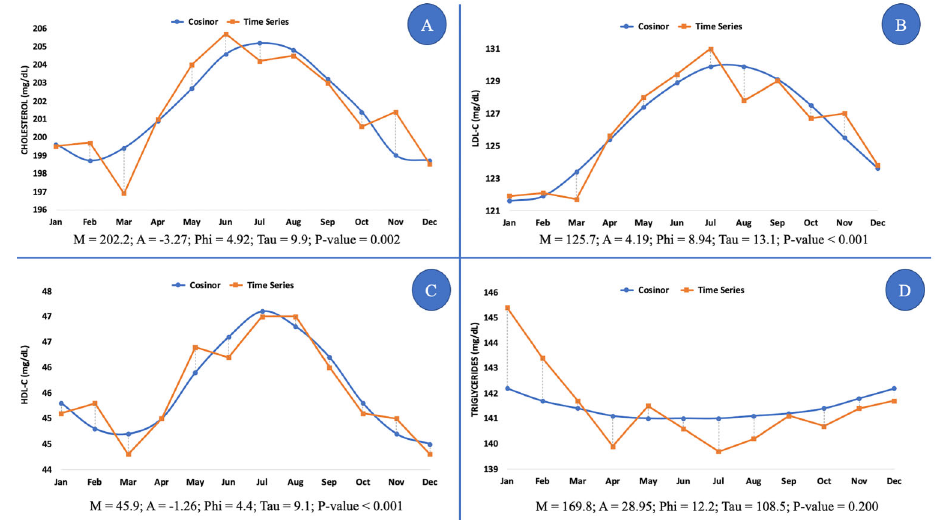
Figure 4. Cosinor analysis for cholesterol ( A ), LDL-C (low-density lipoprotein-cholesterol) ( B ), HDL-C (high-density lipoprotein- cholesterol) ( C ), and triglycerides ( D ) in the whole population during the eight-year study period. Measured parameters: M: MESOR (as mg/dL); A: amplitude (as mg/dL); PHI: acrophase (as months of the year from January to December); TAU: period of rhythm (as months of the year); P-value: probability of biorhythms; n=27,543